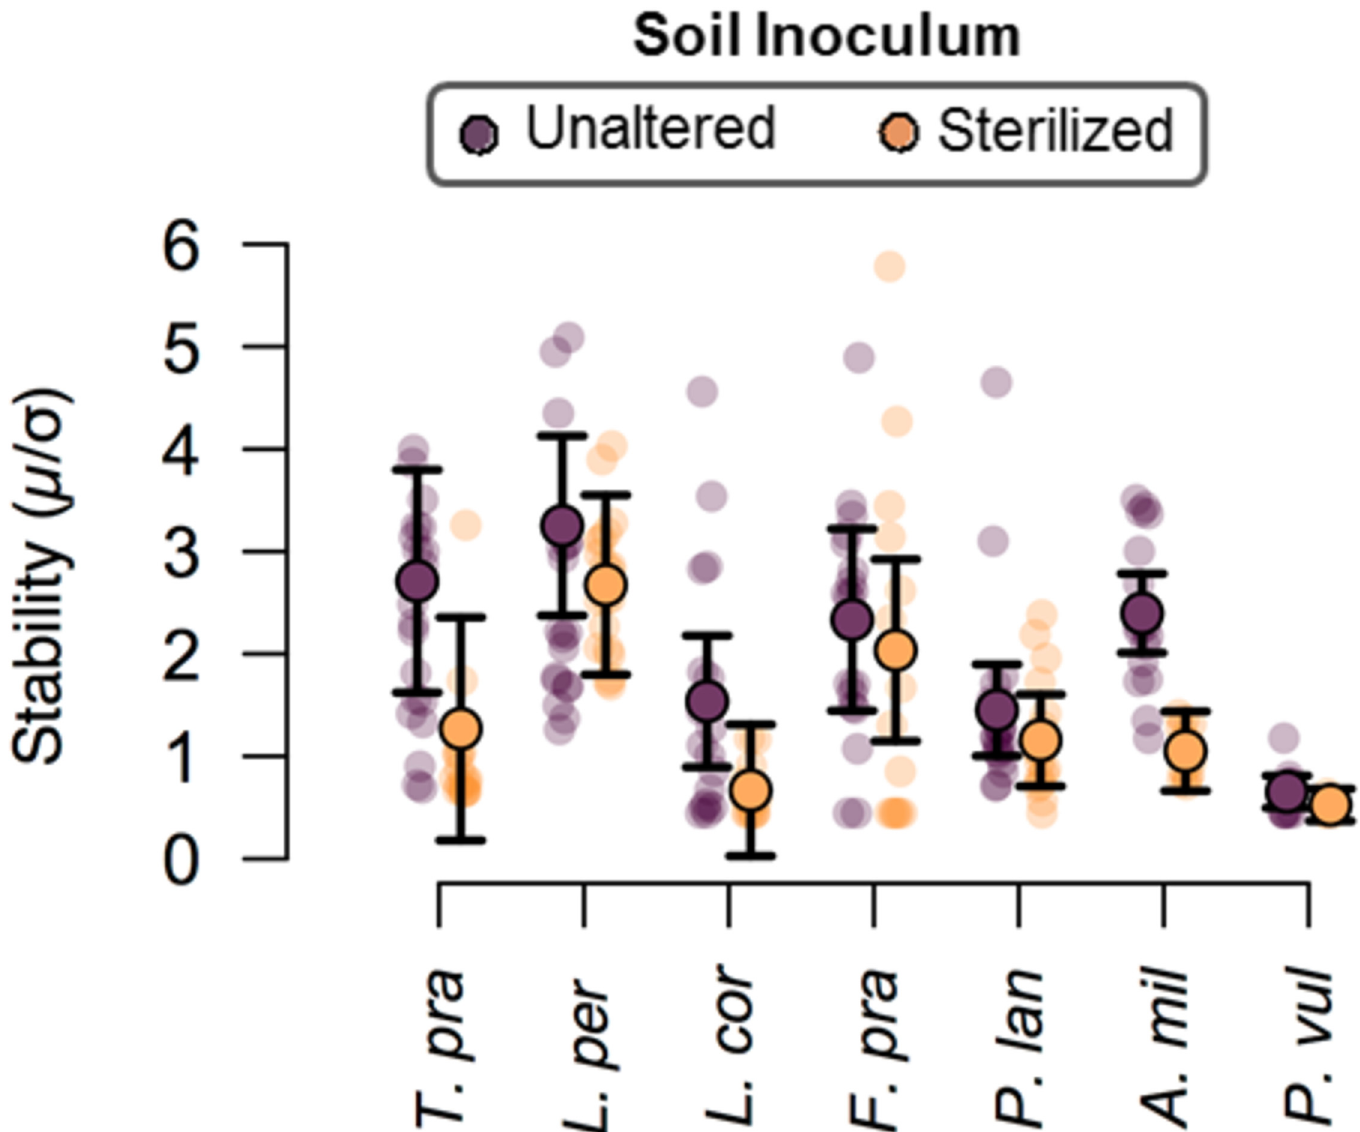
Fig 4. Temporal stability of individual plant species and their contribution to the temporal variation in NAP. Mean values with 95% confidence intervals are shown for the stability of individual plant species. Plant communities inoculated with the unaltered soil are indicated by dark points and light points indicate plant communities inoculated with the sterilized soil. Lightly shaded individual points are values for individual